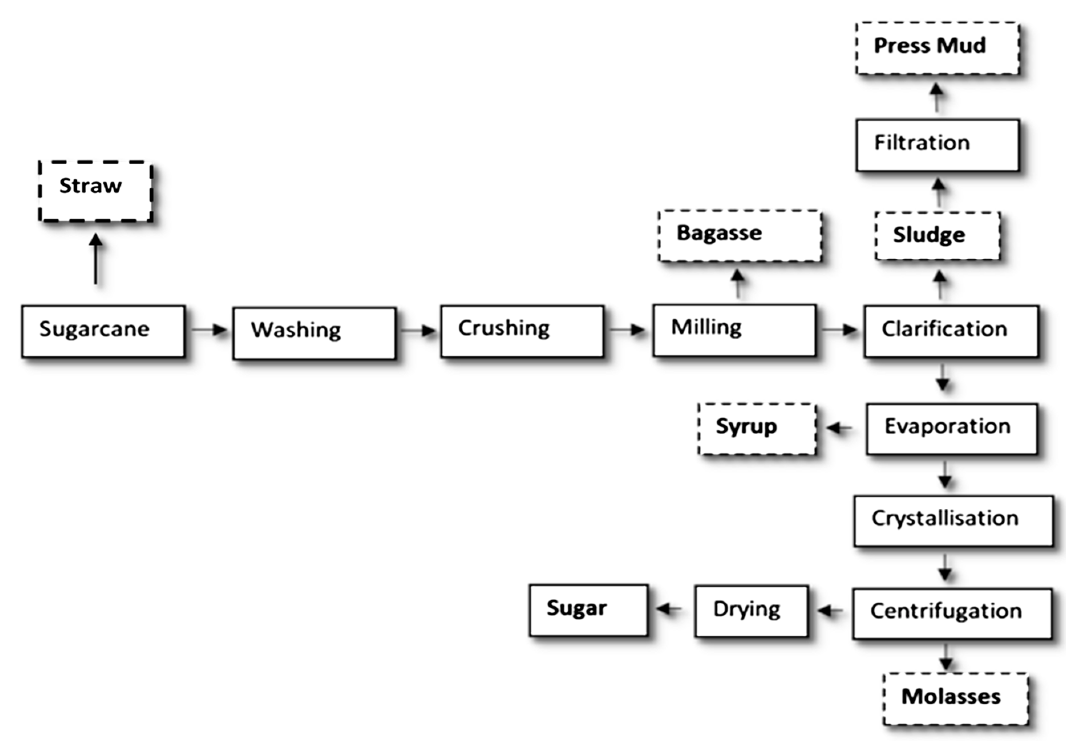
Figure 1. Sugar production process and waste generation [15]. Table 1. Sugarcane by-products, lipophilic extract yield (%) and their main bioactive lipids (%).